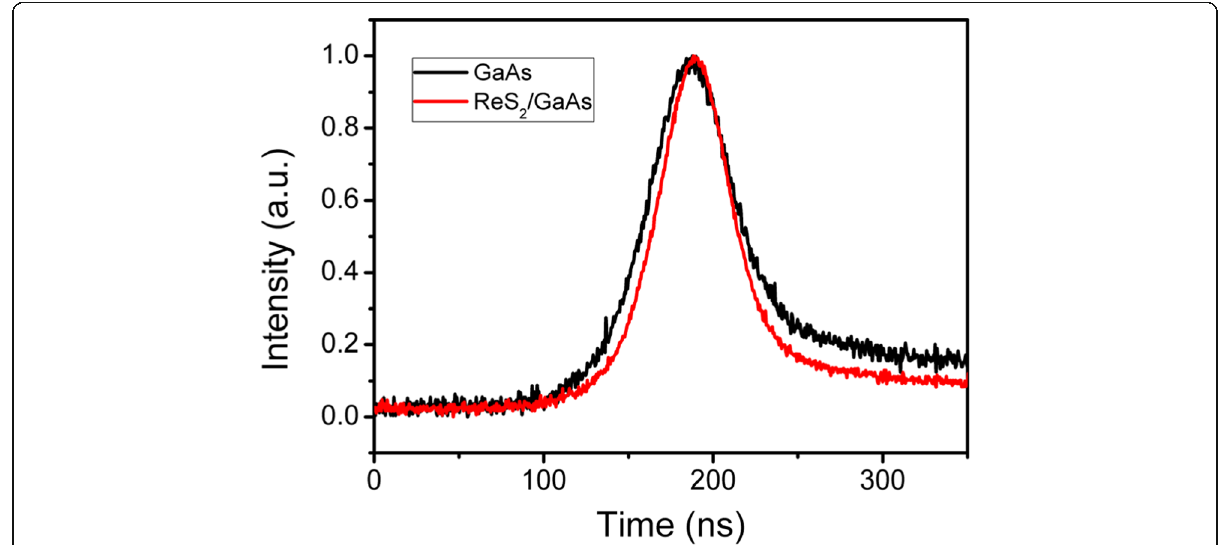
Fig. 6 Profile of the Q-switching laser based on ReS 2 /GaAs or GaAs at the incident pump power of 2.26